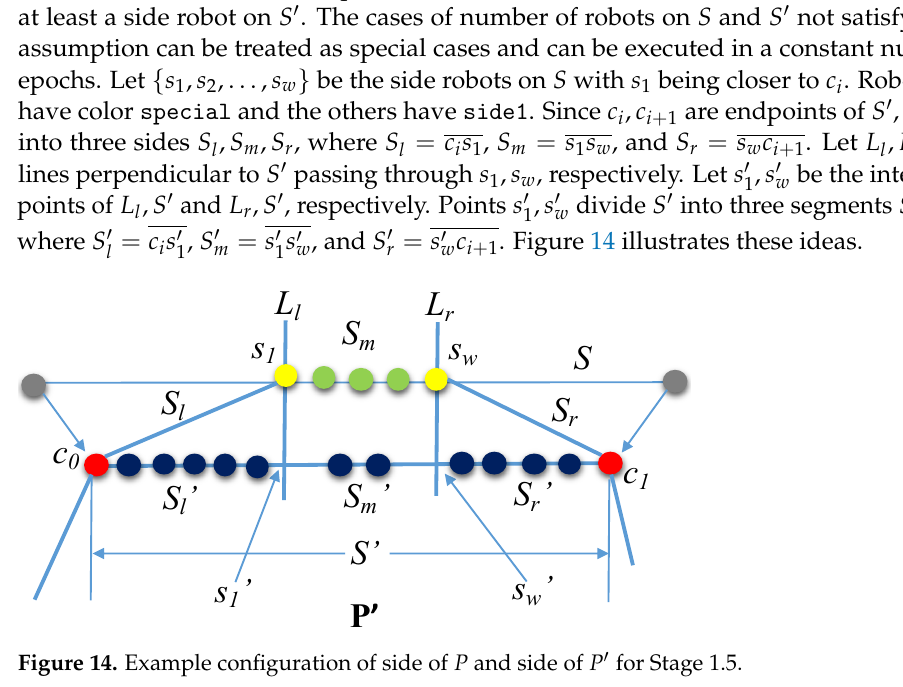
, S (cid:48) , and S (cid:48) with color side2 to S l , S m , and m r l